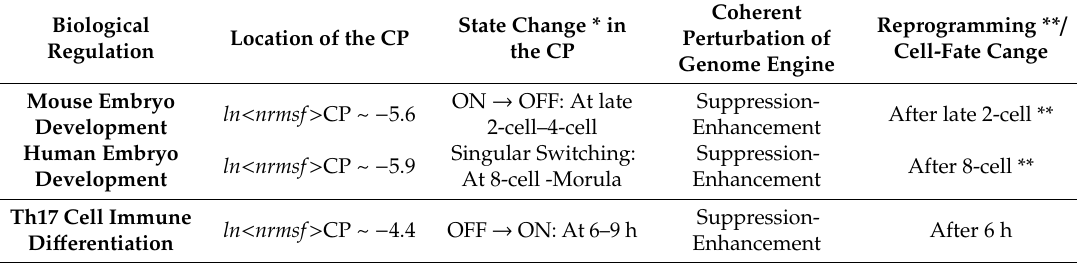
Table 3. Single cell: state change in the CP associated with coherent perturbation of the genome engine. Table provides summary of when and how the state change in the CP with perturbation of the genome engine occurs for mouse and human embryo development, and Th17 cell di ff erentiation (from top to bottom row, respectively). * Cell fate-guiding state change occurs in the CP. ** Reprogramming in mouse and human embryo